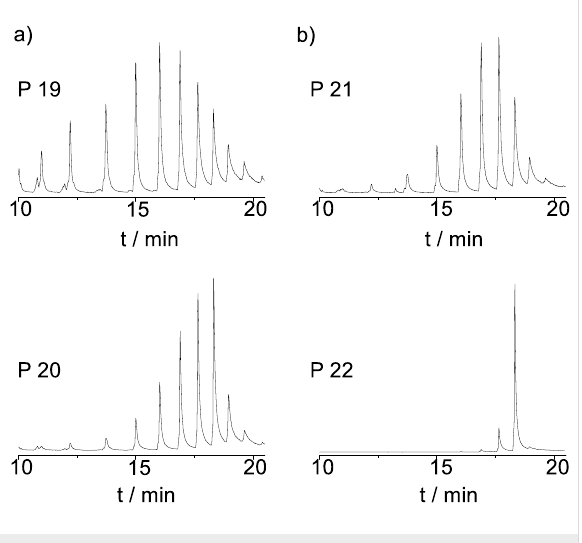
Figure 6: GC-MS study of the acid-catalyzed degradation products of polymers P19 , P20 , P21 , and P22